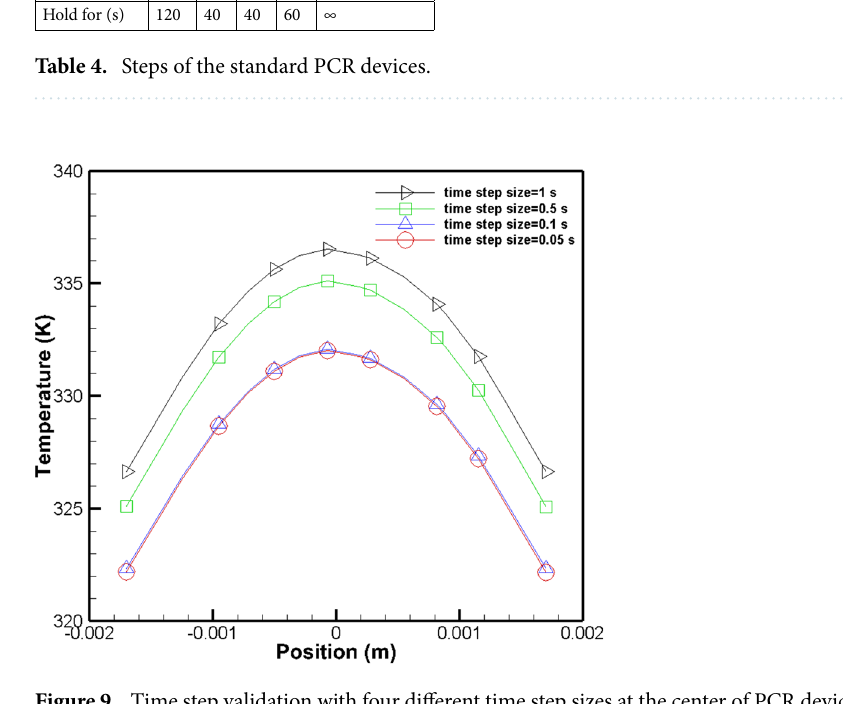
Figure 9. Time step validation with four different time step sizes at the center of PCR